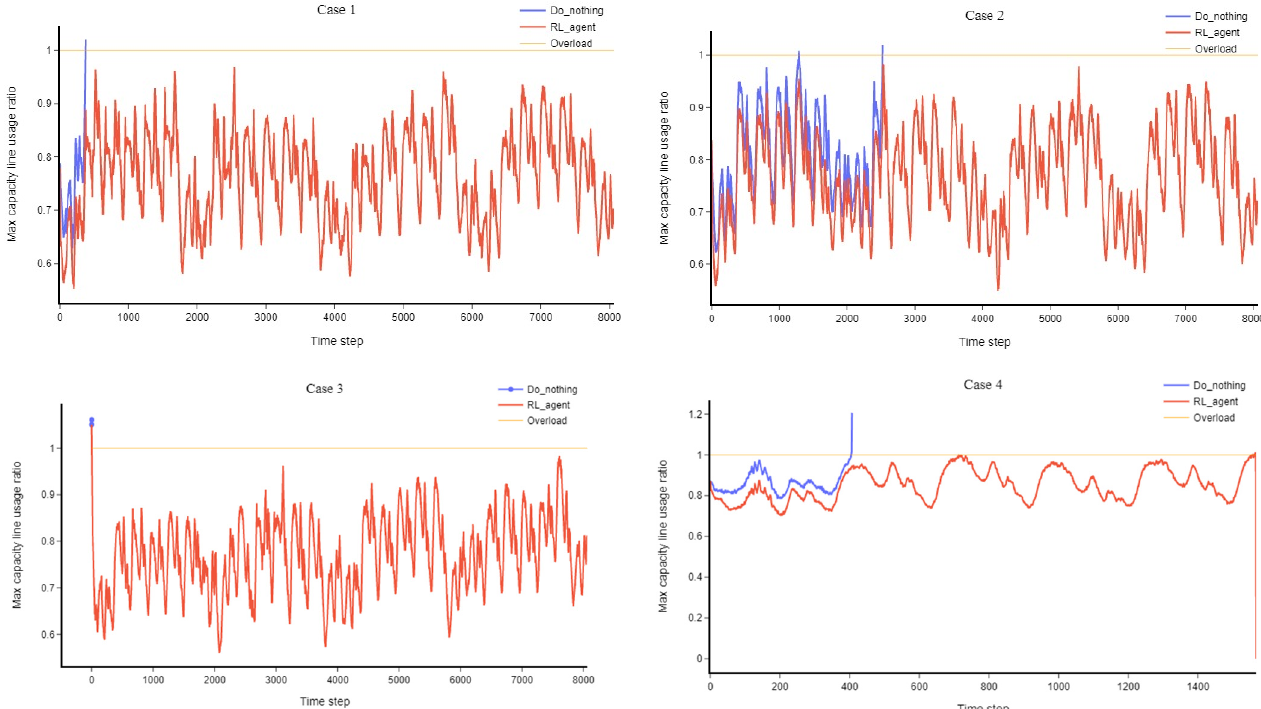
Figure 10. Maximum line capacity usage in the scenarios for the do nothing and DRL